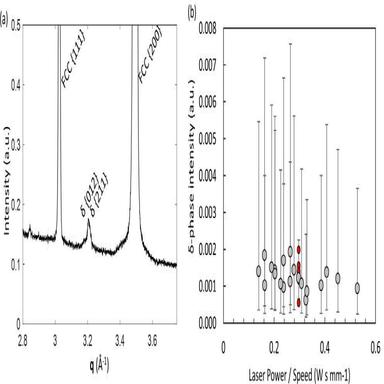
(a) Representative XRD profile on the SR 870 C sample for a 2h scan of 40 to 55. q is the scattering vector (b) d-phase peak intensity versus laser power / scan speed ratio. See for a description of interval calculations. Smaller, red data points are the five columns at the default settings. (For interpretation of the references to color in this figure legend, the reader is referred to the web version of this article.)